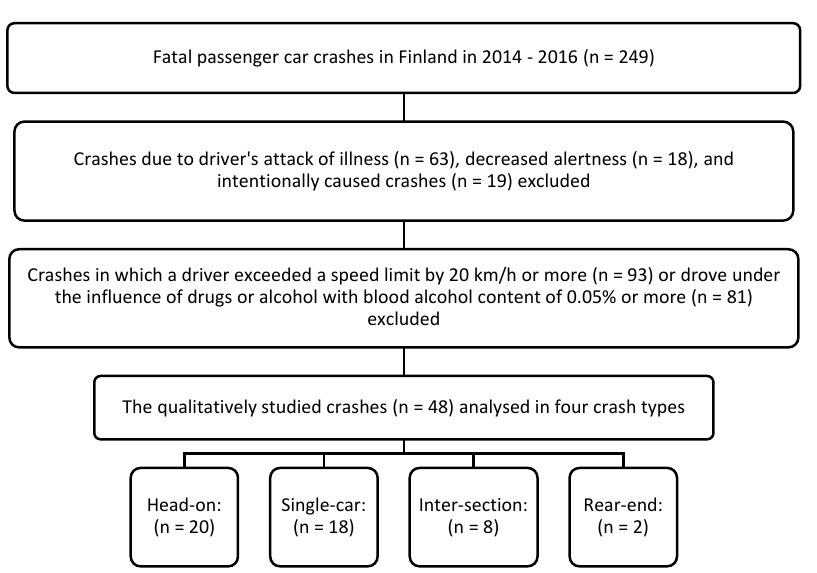
Figure 1. The management of the research data and the data in the four analysed crash types.